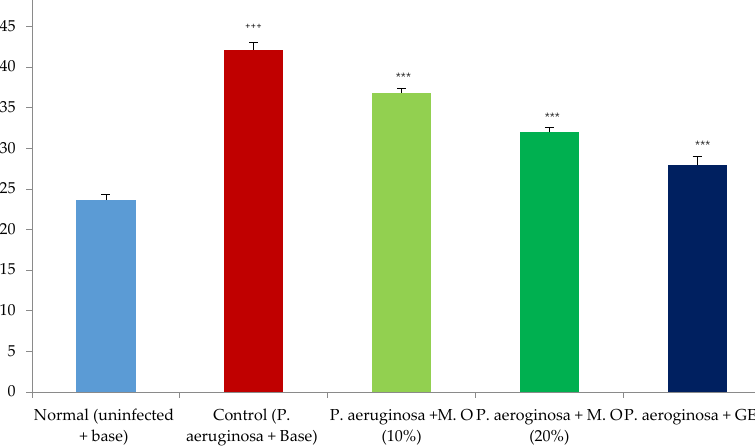
Figure 8. Effect on days of epithelization in P. aeruginosa -infected diabetic animals. All values are mean ± SEM, n = 6, +++ p < 0.001 when compared to normal (uninfected). *** p < 0.001 when compared to control (infected). M.O = M. oleifera leaf extract formulation, GEN = gentamicin (0.1% w / w ).